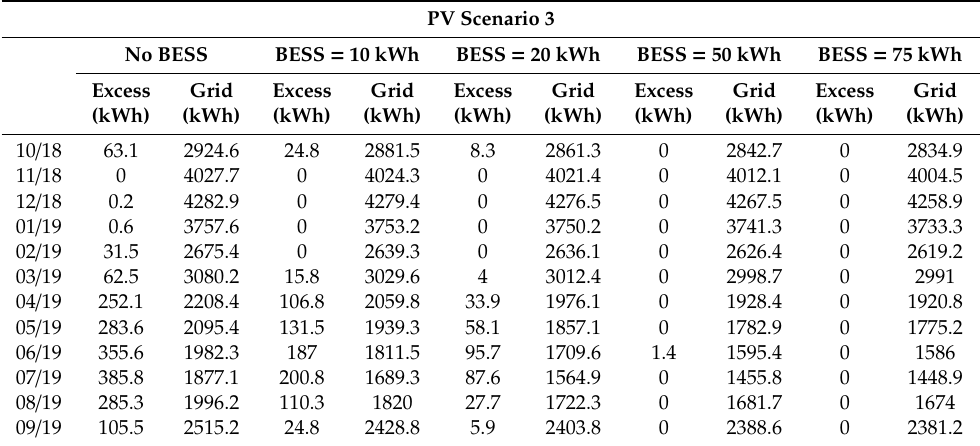
Table A3. Energy sent / taken to / from the grid considering various BESS capacities obtained for PV Scenario 3.